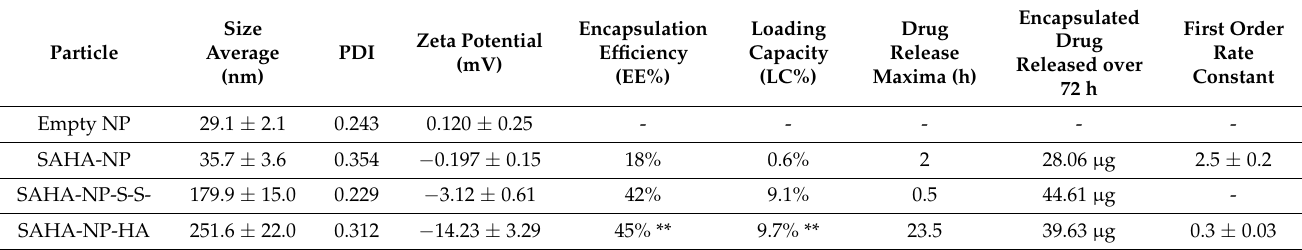
Table 1. Characterization of nanodelivery systems. Four different nanoparticle formulations were analyzed by size (DLS), polydispersity index (PDI; DLS), zeta potential (DLS), encapsulation efficiency (EE%) and drug release profile data. All data shown is average and standard deviation, from a minimum of three independent biological repeats. ** Statistically significant values compared to